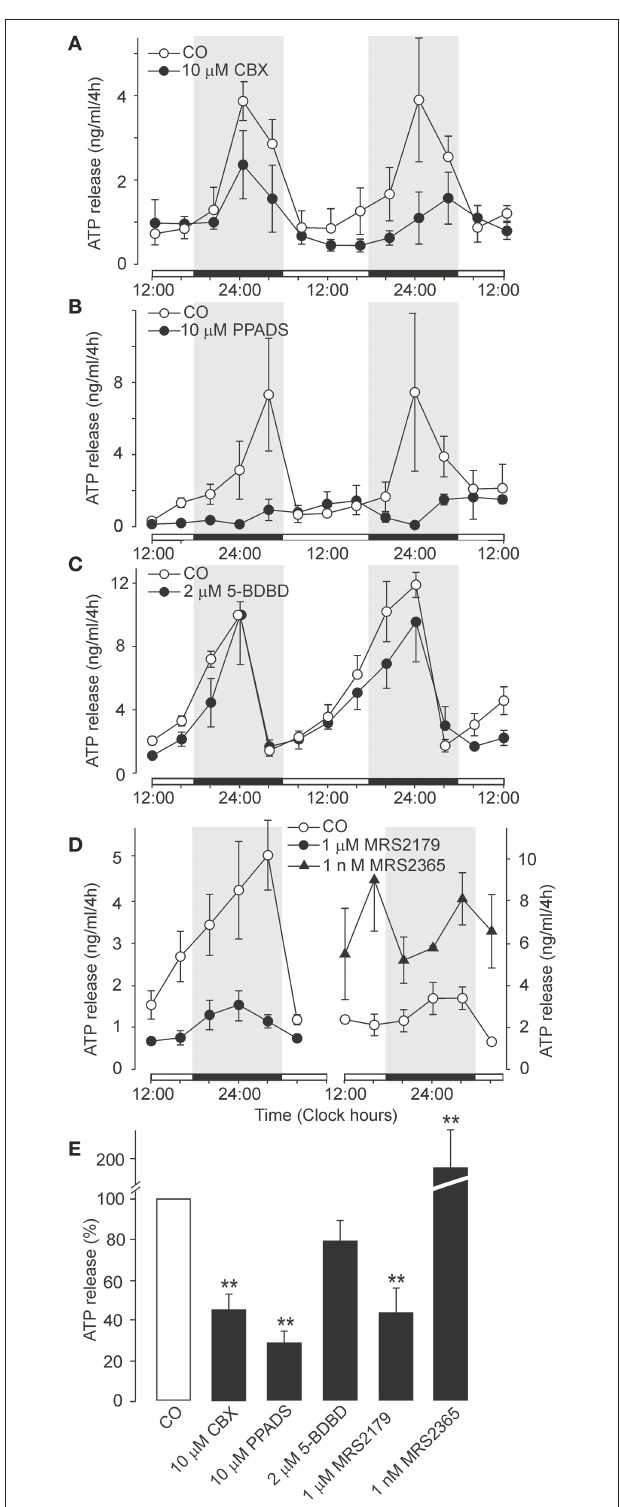
FIGURE 5 | Effects of carbenoxolone and other P2 receptor blockers on the circadian rhythmicity of ATP release. (A) Partial inhibitory effect of the pannexin-1 hemichannel blocker carbenoxolone (CBX). (B) Inhibition by